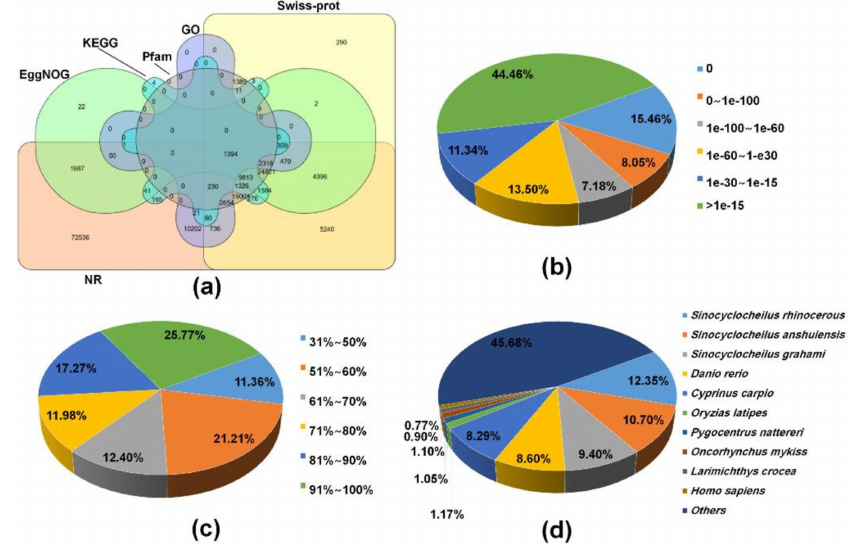
Figure 1. Functional annotation of transcripts from the de novo assembled M. anguillicaudatus transcriptome: ( a ) Venn diagram of all annotated transcripts from the reference transcriptome against non-redundant (NR), Swiss-Prot, Pfam, non-supervised orthologous groups (eggNOG), gene ontology (GO), and Kyoto Encyclopedia of Genes and Genomes (KEGG) databases; ( b ) E-value distribution; ( c ) similarity distribution; and ( d ) species